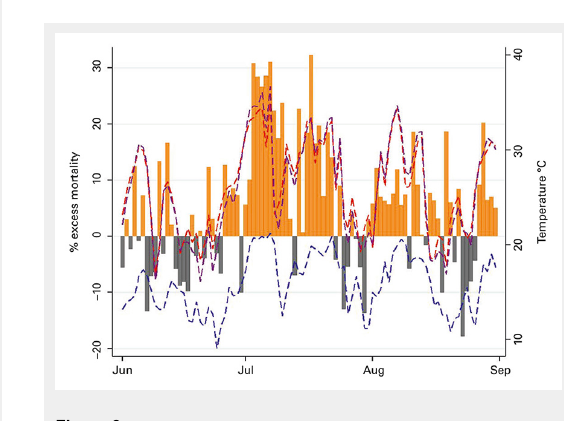
Figure 3 Daily percentage of excess mortality during summer 2015 in Switzerland (vertical bars: orange, positive deviation; grey, negative deviation), and dashed lines showing average daily maximum apparent temperature (purple), maximum daytime (red) and minimum night-time temperatures (blue) across the seven regions.